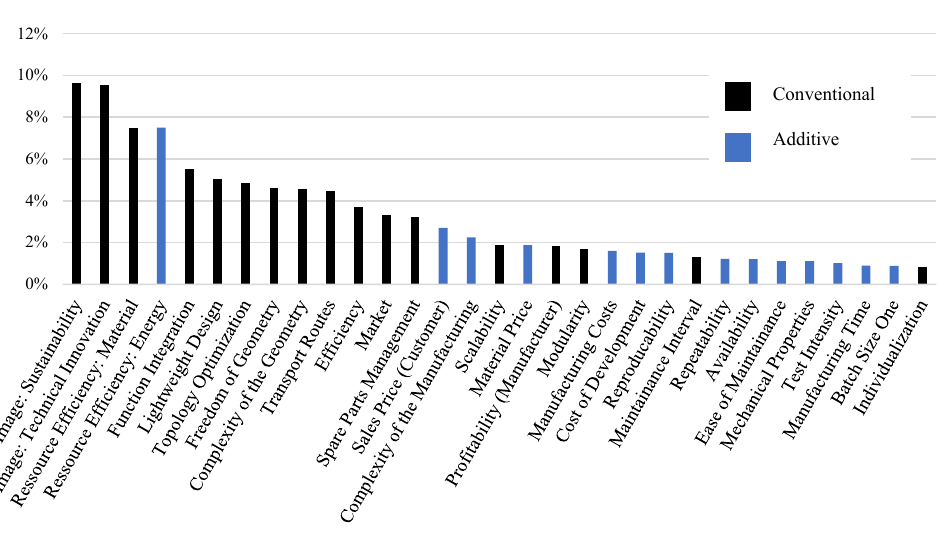
Figure 5. Results of the AHP for the control unit housing.